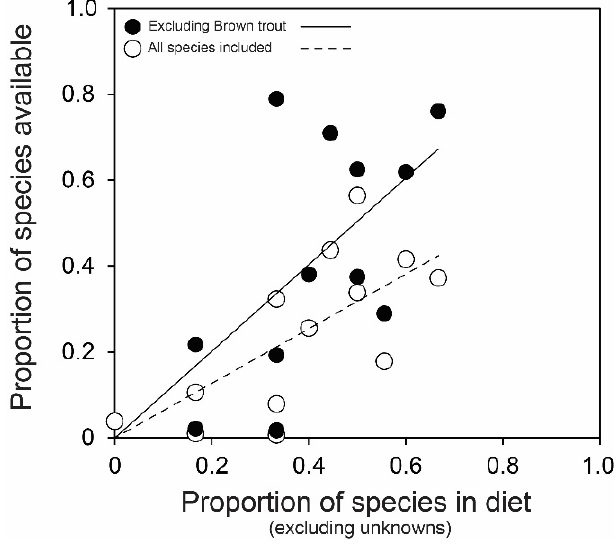
Figure 4. Correlations examining the proportion of a prey species in the diet of Brown Trout ( Salmo trutta ) in relation to proportional availability in the stream. We considered that cannibalism may affect these values; therefore, separate correlations were conducted with and without Brown Trout as a prey item. Closed circles are values in which BRT were excluded, and open circles included all species.